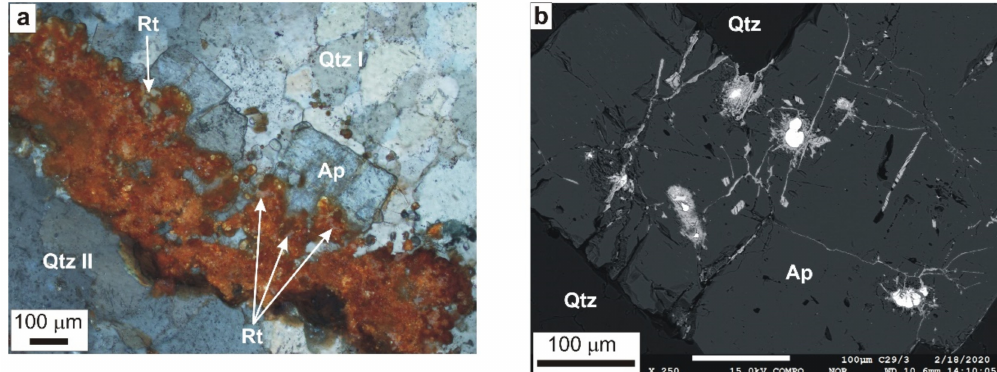
Figure 13. ( a ) Subhedral crystals of fluorapatite (Ap) in quartz (Qtz), replaced by unspecified supergene U mineral (orange– brown), which represent complete pseudomorphosis after the original uraninite veinlet. Small grains of rutile (Rt) are also enclosed by supergene U mineral. ( b ) Small cavities and cracks in fluorapatite (Ap) are filled with uraninite (white) and supergene uranyl minerals (light grey). The host mineral is quartz (Qtz). Picture a—transmitted light, PPL (photo: Š. Ferenc), picture b—BSE (photo: T. Mikuš).